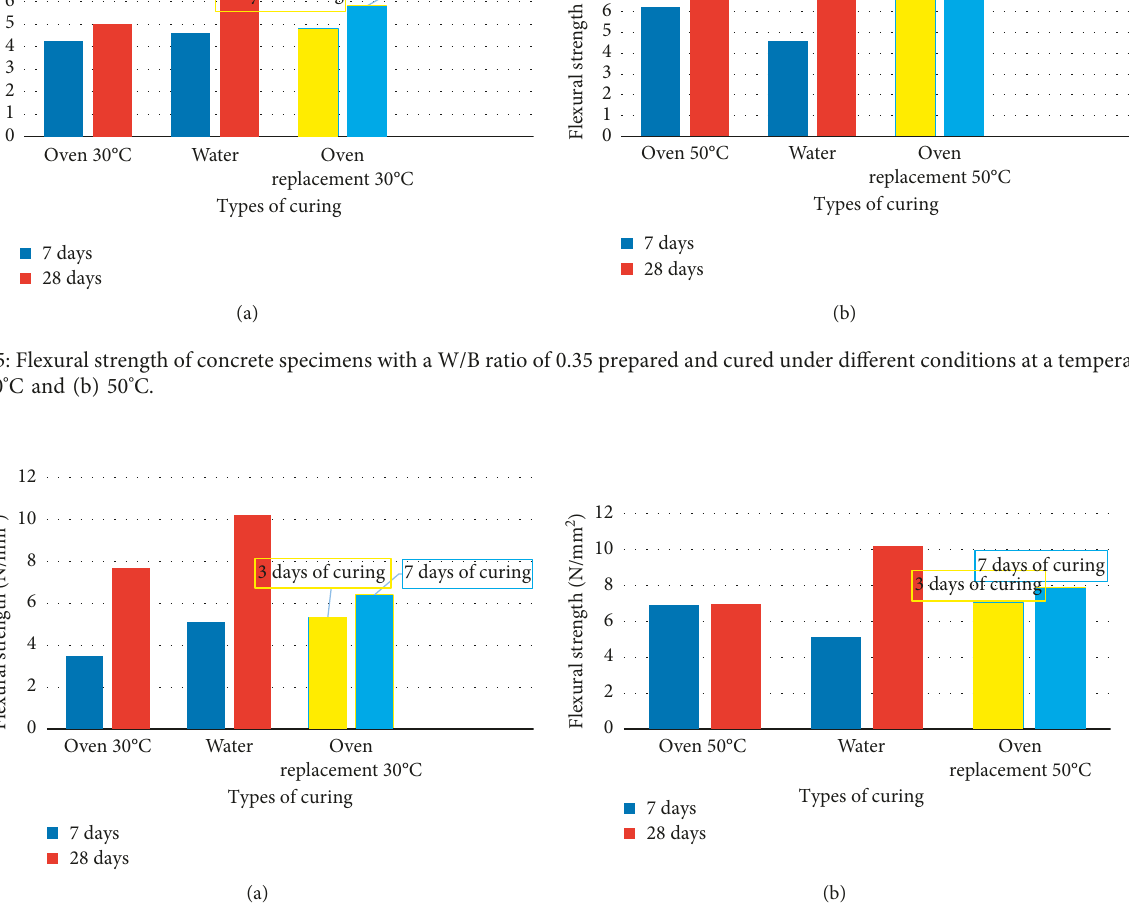
Figure 6: Flexural strength of concrete specimens with a W/B ratio of 0.4 prepared and cured under different conditions at a temperature of (a) 30 ° C and (b) 50 °